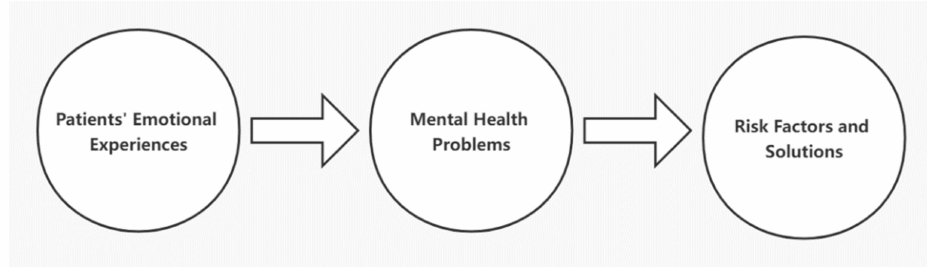
Figure 1. Schematic of the conceptual